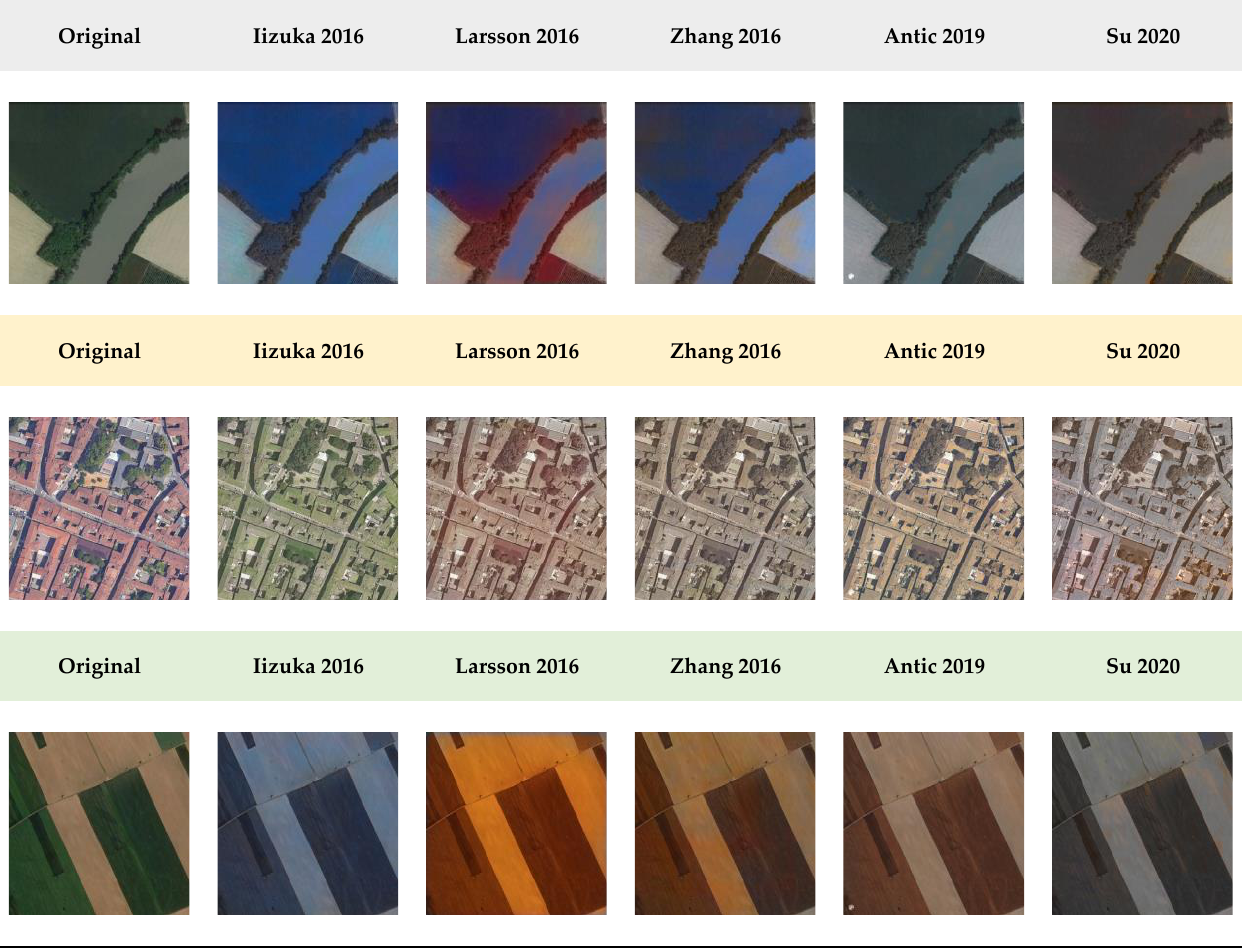
Figure 2. Some examples of colorization outputs obtained with the selected state-of-the-art techniques using aerial-scale images with urban and rural environments.